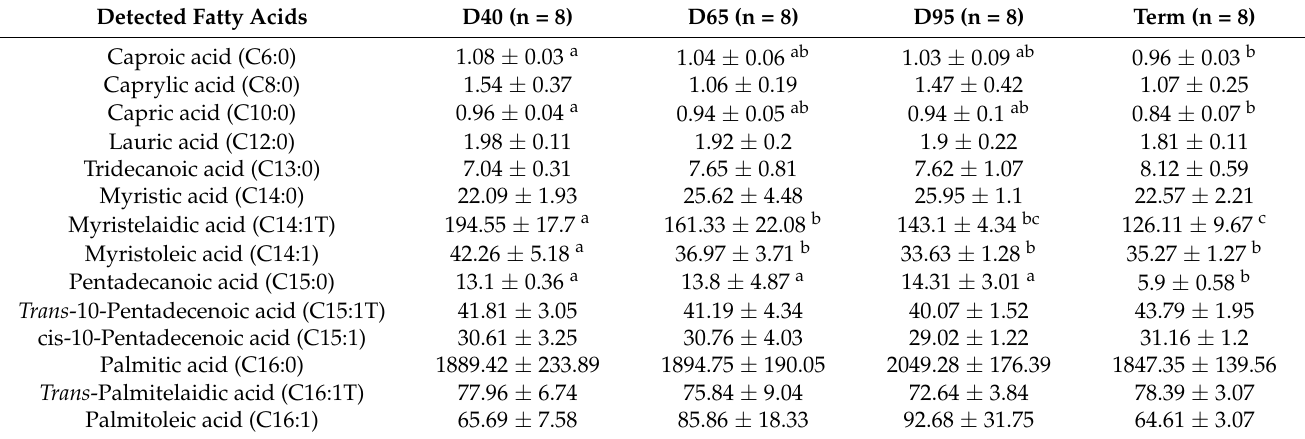
Table 2. Comparison of the fatty acid concentrations in the placentae from different gestation peri- ods.